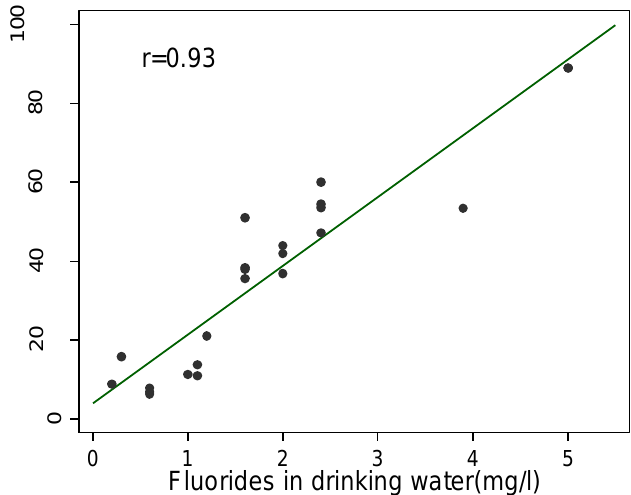
Figure 4. Correlation of dental fluorosis with drinking water fluoride.